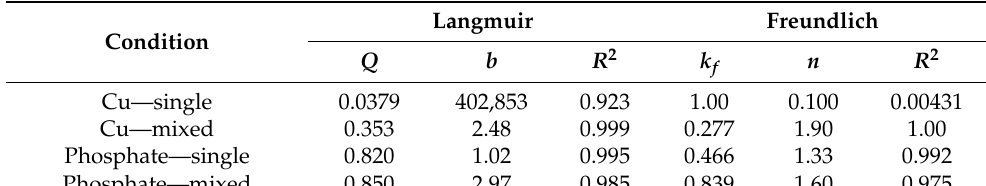
Table 2. The parameters were calculated from Langmuir and Freundlich isotherm models under single and mixed conditions. Condition